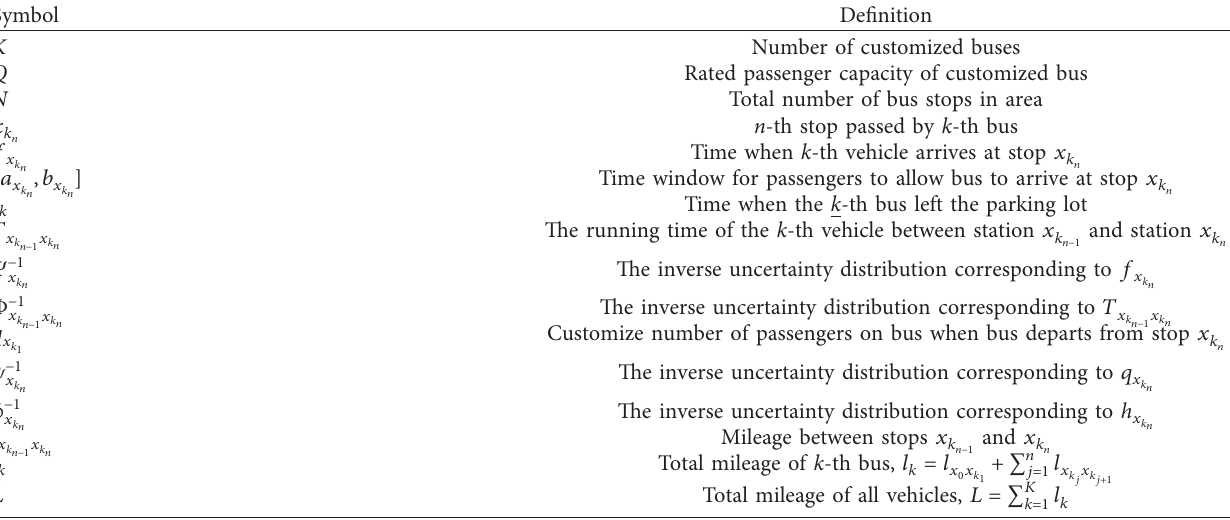
Table 1: Definition of each symbol in